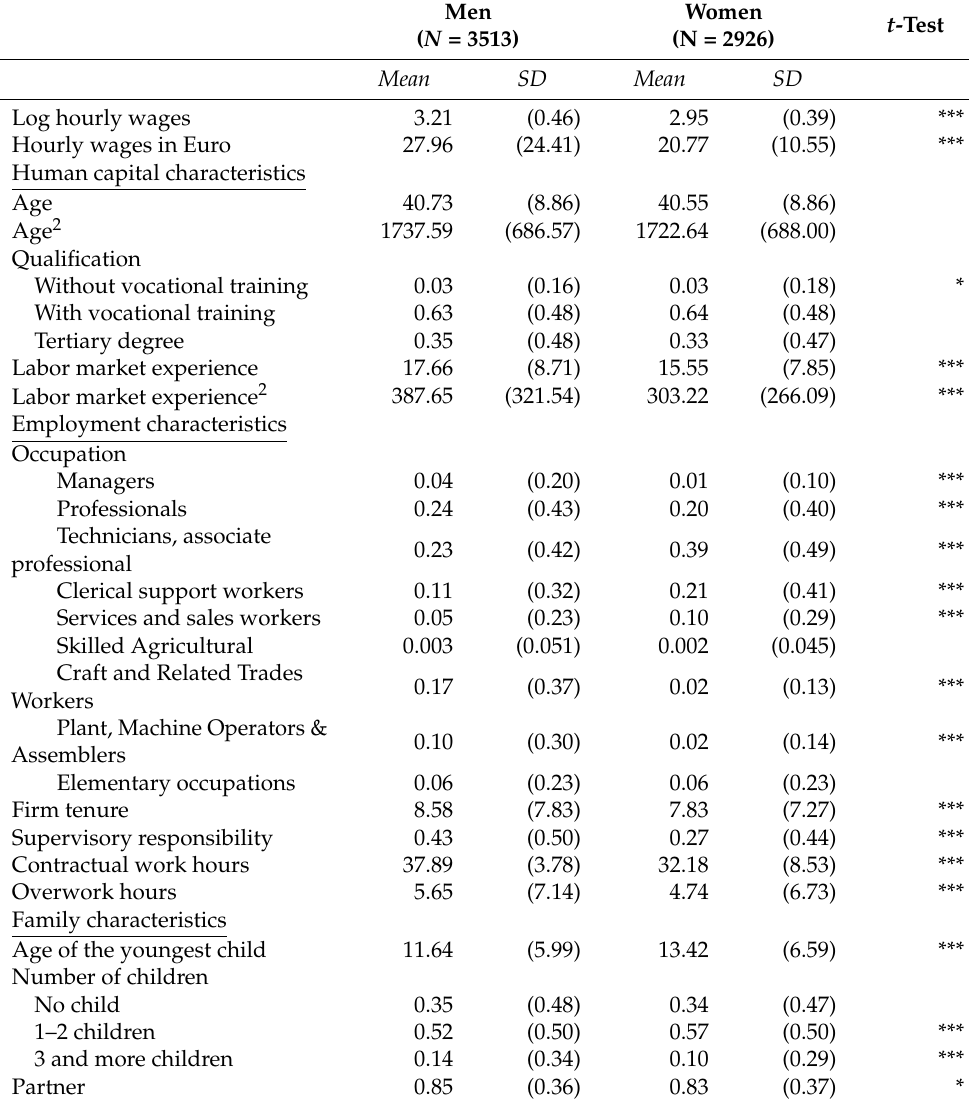
Table 1. Individual characteristics ( N = 6439) split by